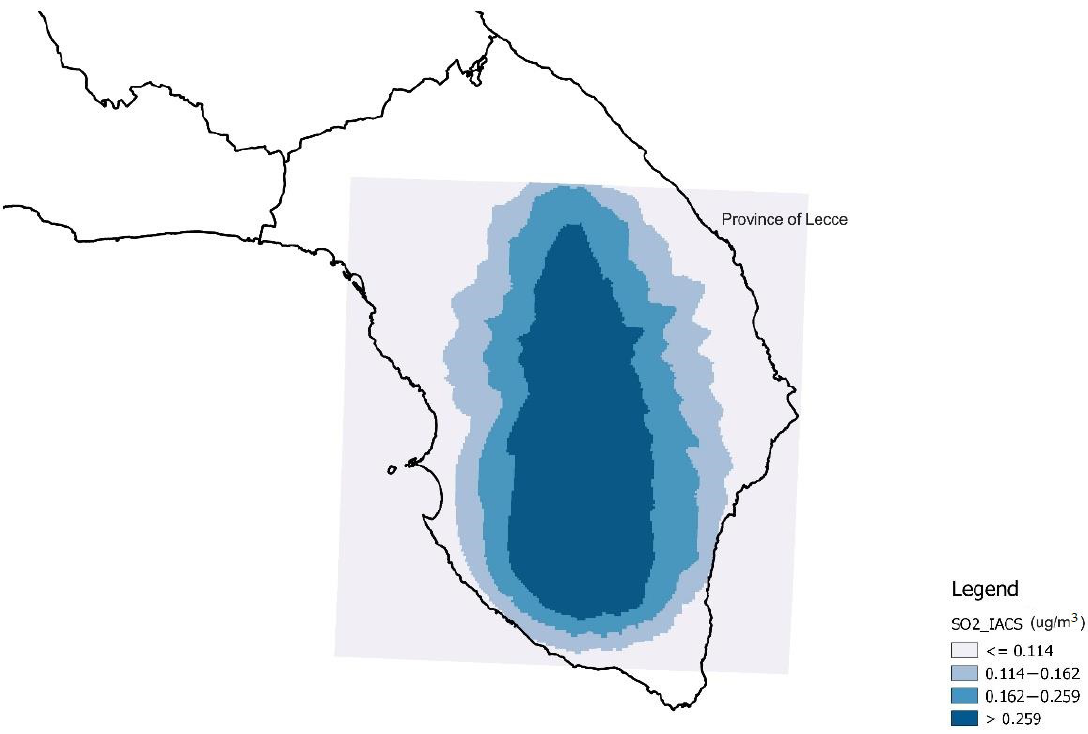
Figure 3. Exposure classes according to the quartiles of the sulfur dioxide distribution of the Industrial Area of Central Salento (IACS) (SO 2 _IACS), attributed to georeferenced subjects (values in µg/m 3 ).